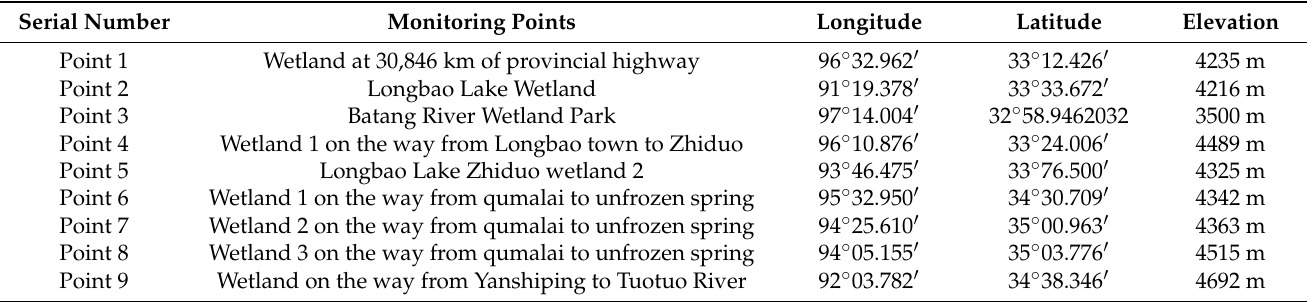
Table 1. Wetlands in the source region of the Yang tz e River were chosen for continuous observa- tion.